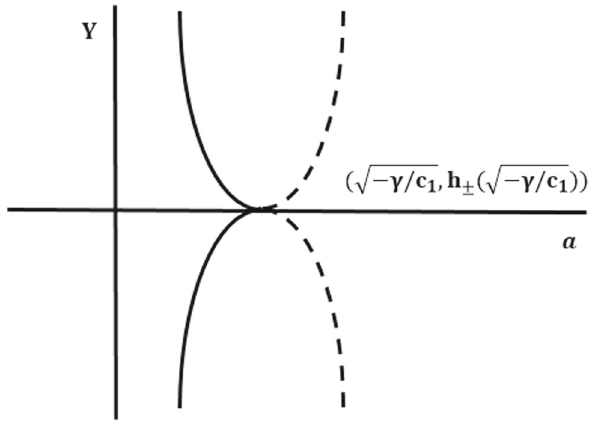
Fig. 3 Matching graphs at the inflection point